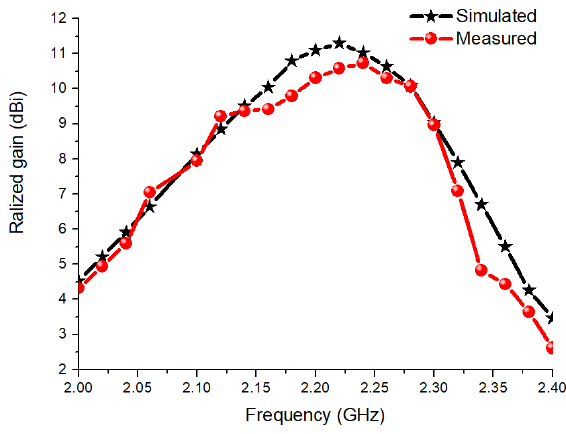
Figure 15. Simulated and measured realized